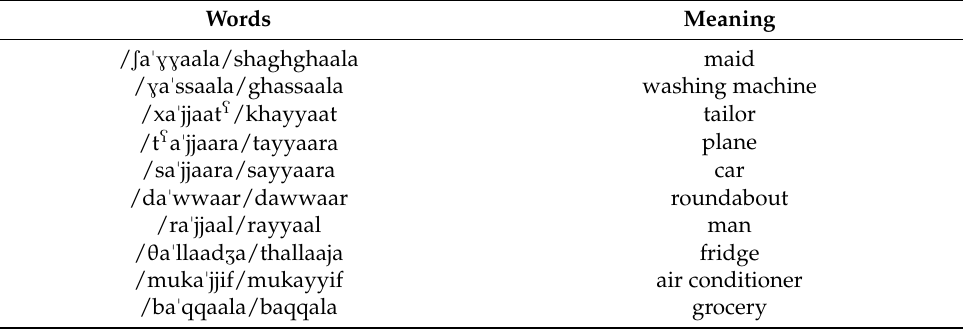
Table 2. The names of the objects used in the study test and their